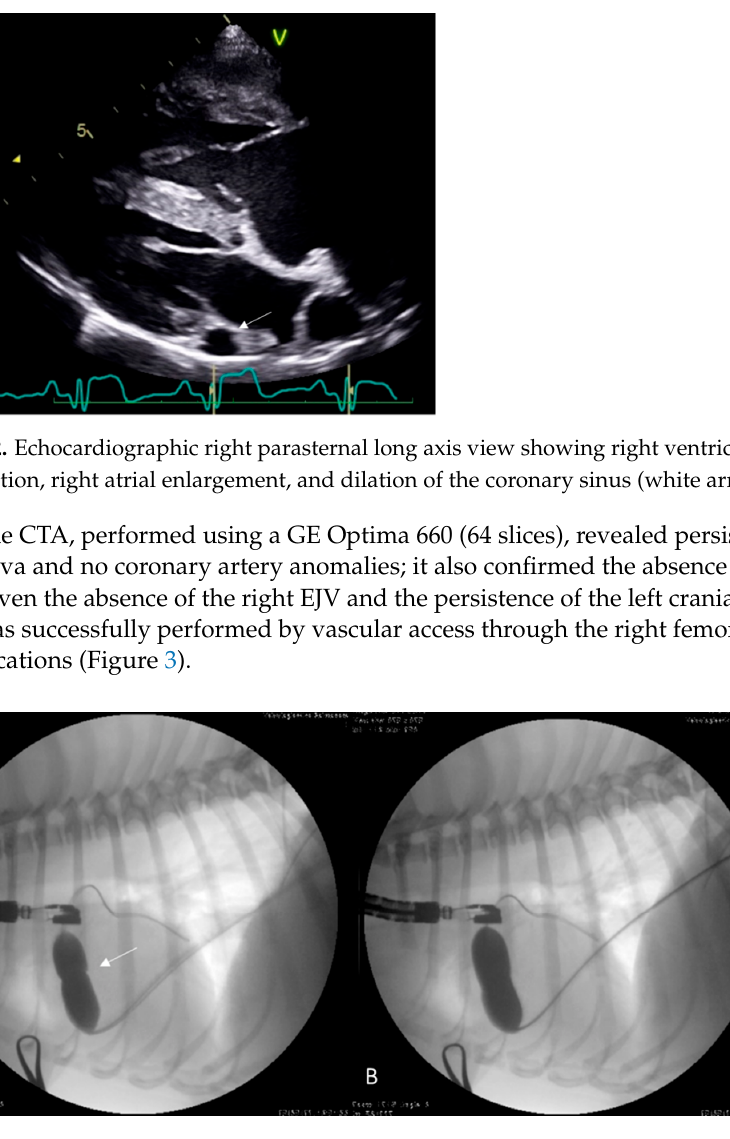
Figure 3. Fluoroscopic images of the pulmonary balloon valvuloplasty in Case 2 performed using vascular access through the right femoral vein. ( A ) The balloon was partially inflated across the pulmonary valve stenosis. The stenosis was identified by the waist, which was seen as the balloon was inflated (white arrow). The guidewire passed into the caudal vena cava, through the right atrium and right ventricle, and out into the pulmonary artery. ( B ) The balloon was completely inflated causing the waist to abruptly reduce its